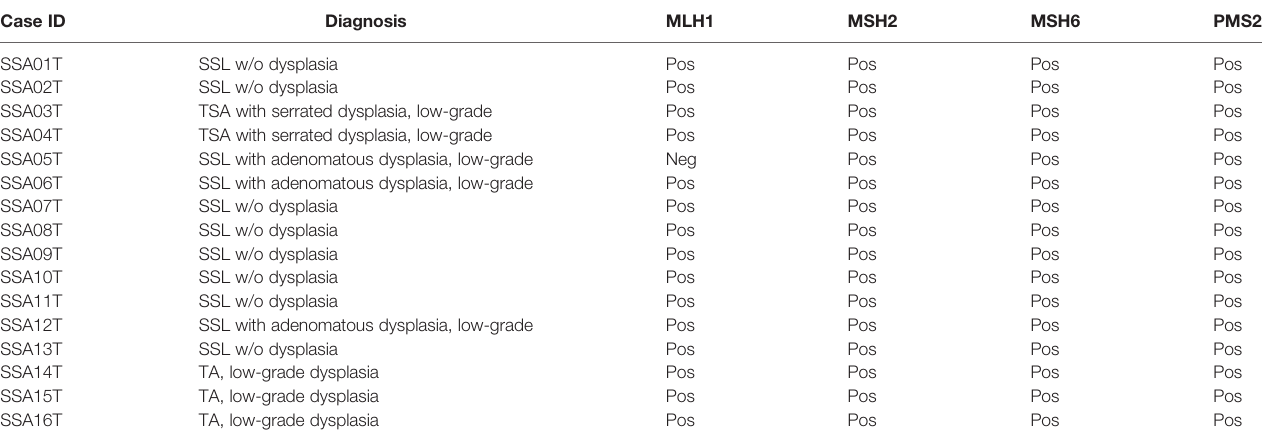
TABLE 1 | Histologic and immunohistochemical characterization (mismatch repair proteins) of the samples included in the